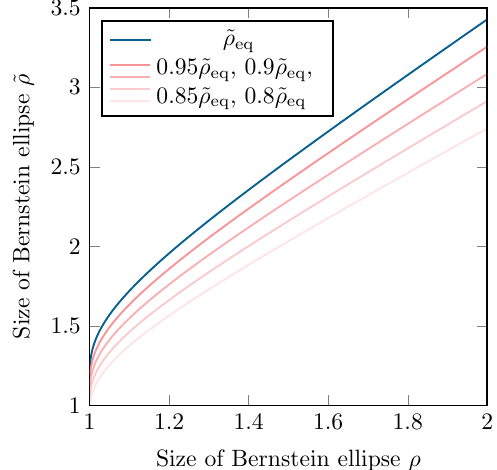
Figure 7. The size of E ˜ ρ as a function of the size of E ρ when using the tanh map. ˜ ρ eq corresponds to the maximally achievable value of ˜ ρ